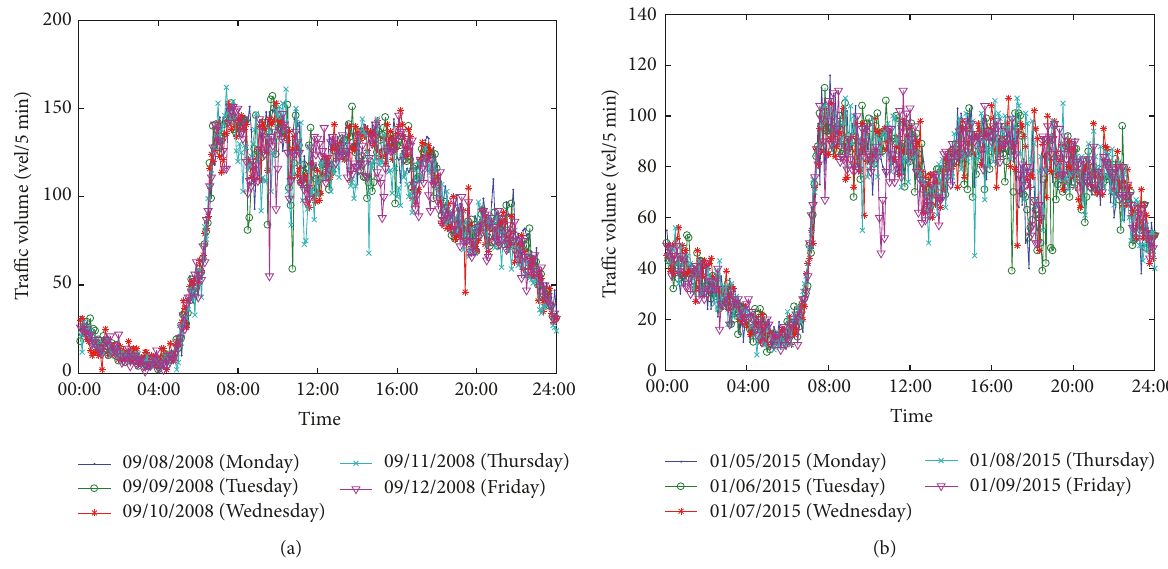
Figure 7: An example for illustrating the “week pattern”: (a) urban expressway and (b) urban arterial road.